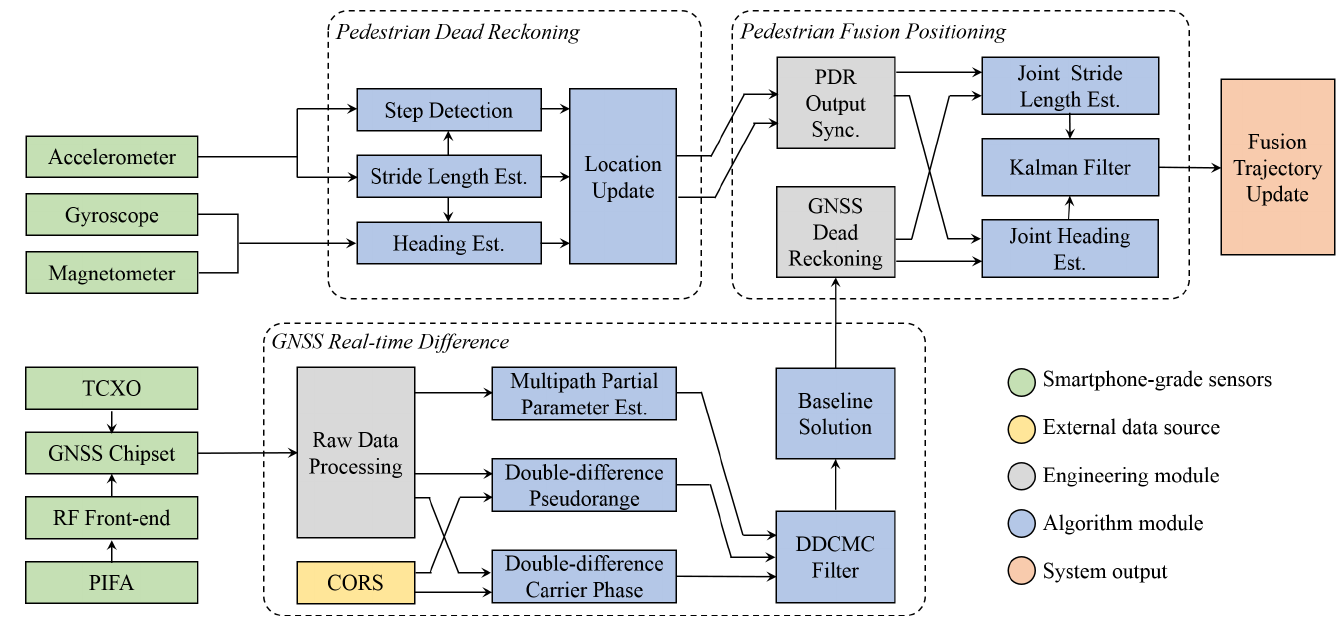
Figure 1. Block diagram of PDR and GNSS fusion framework based on smartphone-grade